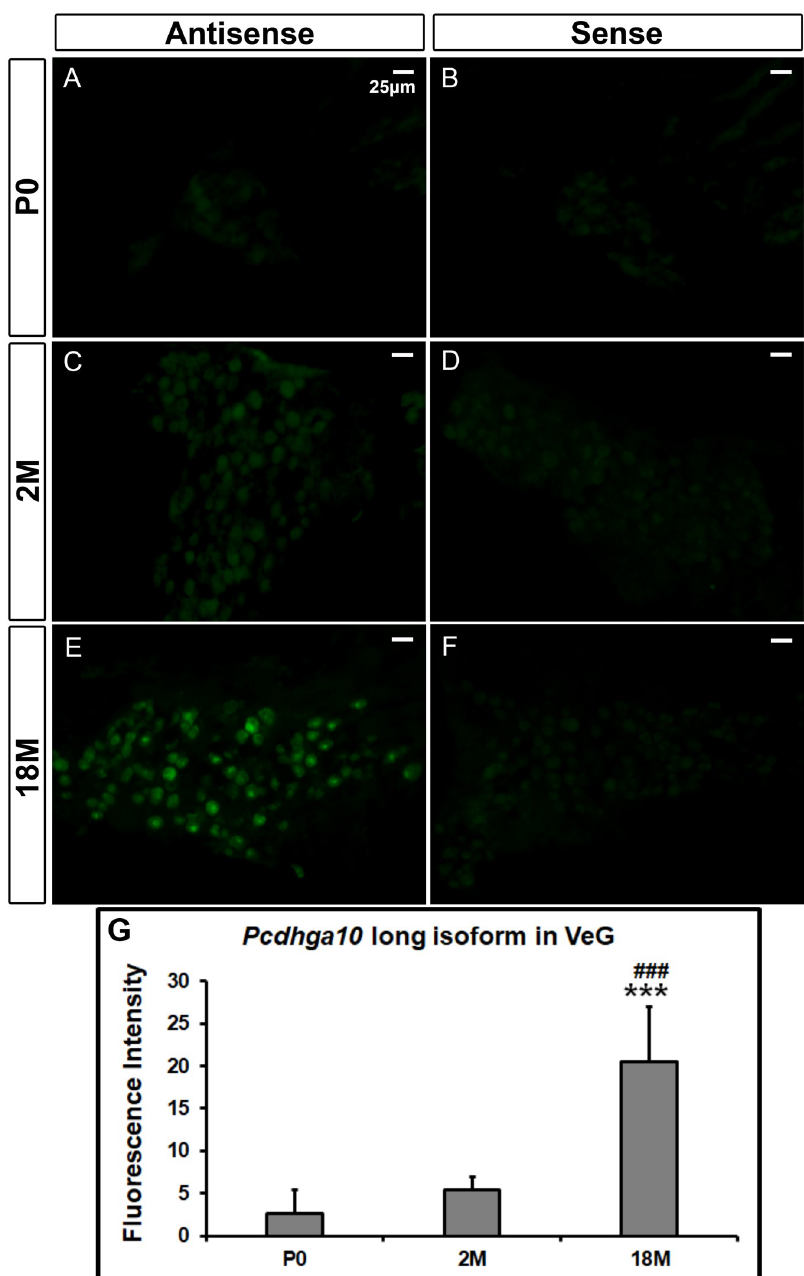
Fig 5. Fluorescent in situ hybridization of the long isoform of Pcdhga10 mRNA in mouse vestibular ganglia. At P0 (A) and 2M (C), the fluorescent signals of the antisense probe of the long isoform are absent (or similar to that in the negative controls at the same ages) (B & D), whereas at 18M (E), the fluorescent signal of the antisense probe is much stronger than the negative control (F). P0, postnatal day 0; 2M and 18M, 2 and 18 months old, respectively. VeG, vestibular ganglia. Scale bar, 25 μ m. ��� and ### denote p < 0.001 when the 18M group is compared with P0 and 2M, respectively (n = 4 mice/group).